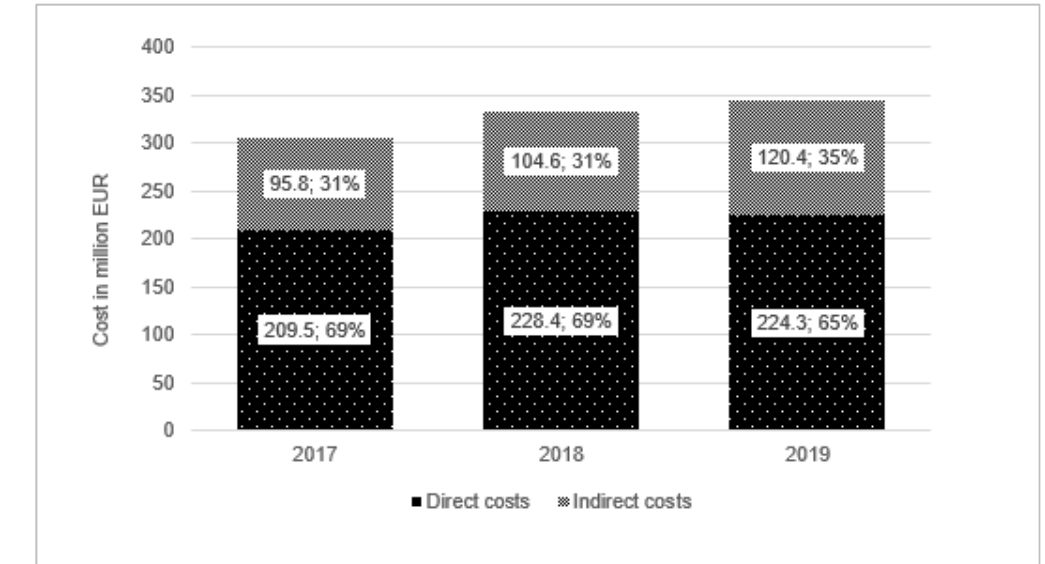
Figure 1. Total expenditures for breast cancer treatment in Poland.